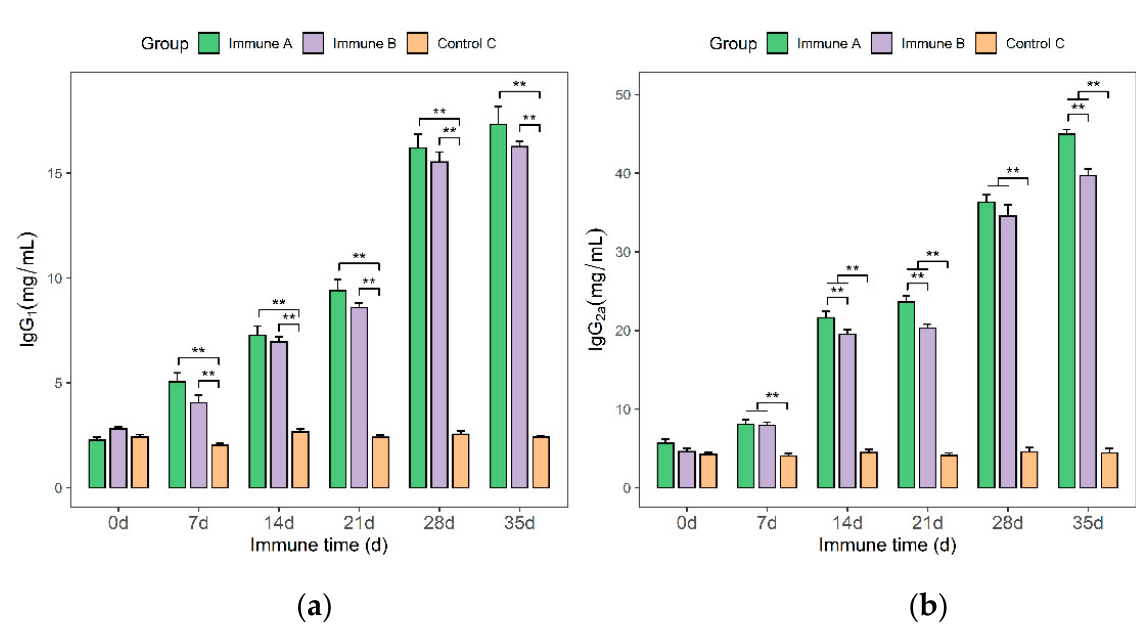
Figure 7. Serum IgG 1 and IgG 2a levels of piglets in the different immunization groups. ( a ) From day 7, the differences between groups A and B (vaccinated) and group C (control) were highly significant, and the IgG 1 level gradually increased over time in the former two groups. ( b ) From day 7, the differences between groups A and B and group C were highly significant, and the IgG 2a gradually increased over time in the former two groups. ** p < 0.01 shows a highly significant difference.